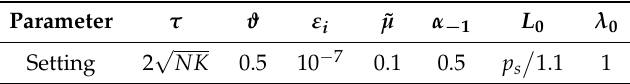
Table 1. The parameter settings of the